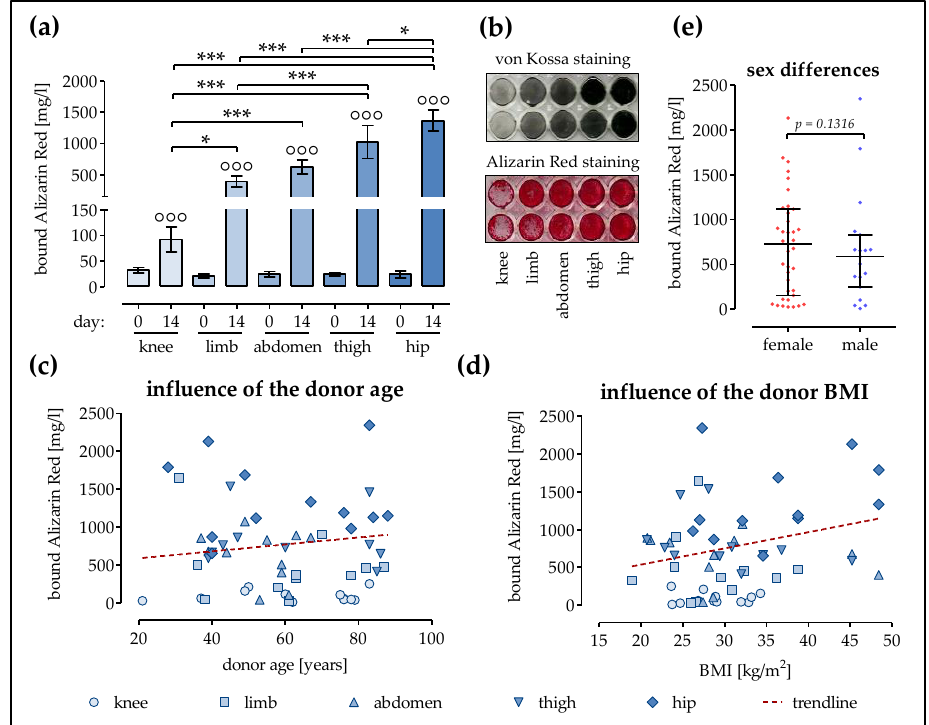
Figure 3. The formation of mineralized matrix by Ad-MSCs varies depending on the donor site. Ad-MSCs derived from adipose tissue of the knee ( N = 12), limb ( N = 11), abdomen ( N = 11), thigh ( N = 12), and hip ( N = 12) were osteogenically differentiated for 14 days. ( a ) Matrix mineralization was quantified by Alizarin Red staining on days 0 and 14 of differentiation; ( b ) Representative scan of von Kossa- and Alizarin Red-stained Ad-MSCs from the different donor sites; ( c ) Mineralized matrix formed by differentiated (day 14) Ad-MSCs as a function of the donor age; ( d ) Mineralized matrix formed by differentiated (day 14) Ad-MSCs as a function of the donor BMI; ( e ) Comparison of the matrix mineralization of differentiated (day 14) Ad-MSCs from male and female donors; °°° p < 0.001 when comparing day 0 with day 14 within each group; * p < 0.05 and *** p < 0.001 as indicated.